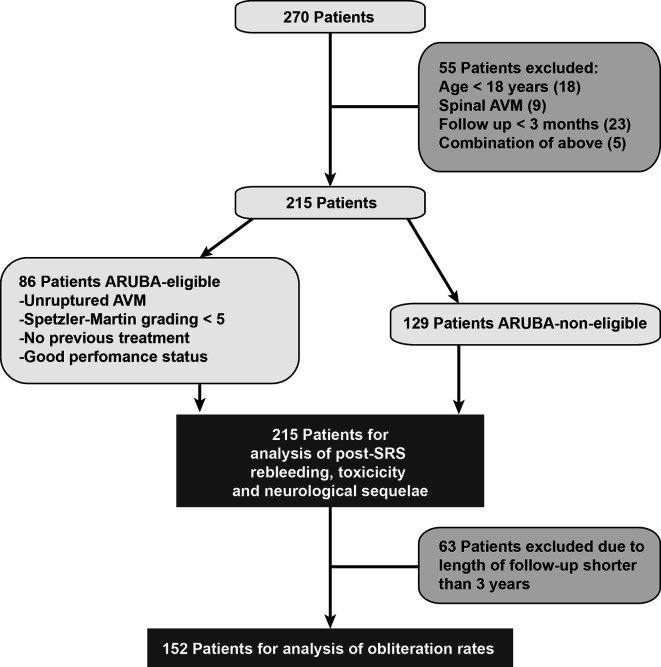
Patient inclusion scheme.